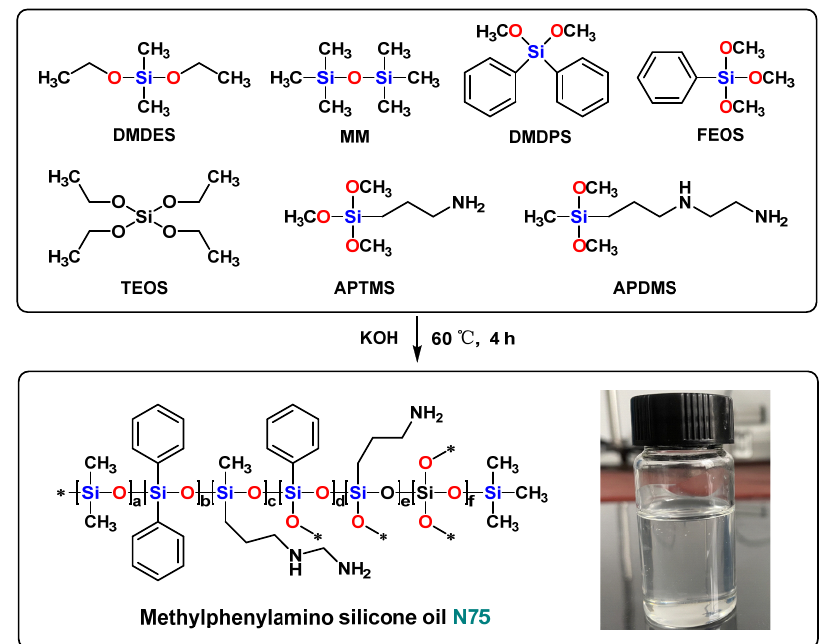
Figure 1. Synthesis of methylphenylamino silicone oil (N75).